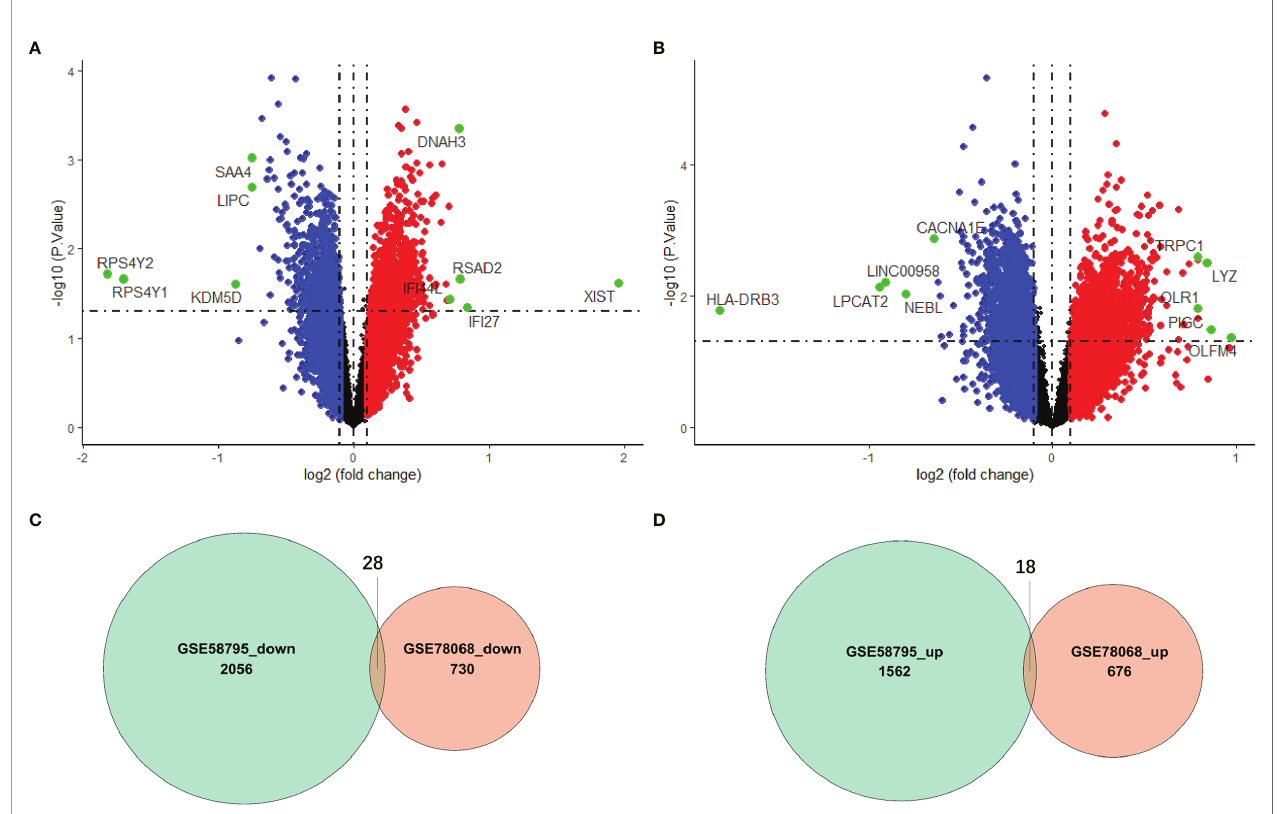
FIGURE 2 | Identi fi cation of differentially expressed genes (DEGs). (A) Volcano plot of DEGs between responders and nonresponders in IFX treatment for RA in the GSE78068 dataset. (B) Volcano plot of DEGs between responders and nonresponders in IFX treatment for RA in the GSE58795 dataset. (C) The Venn diagram of the concordant downregulated genes in the two datases. (D) The Venn diagram of the concordant upregulated genes in the two